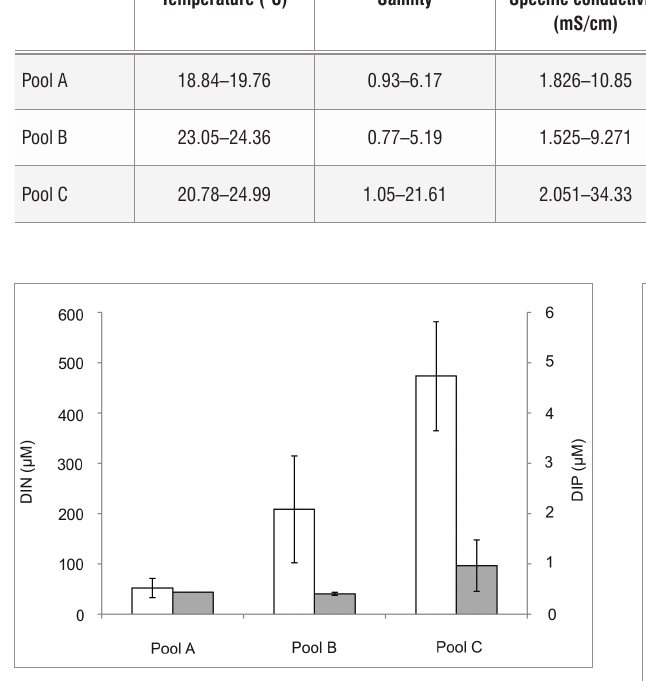
pH Dissolved oxygen Turbidity (NTU) (mS/cm) (mg/L)